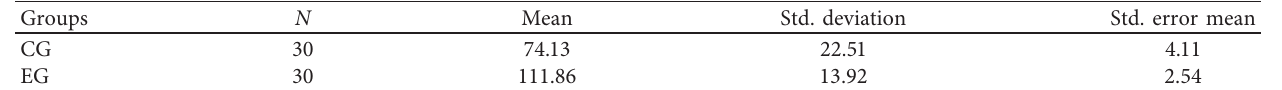
Table 7: Means and standard deviations of both groups on the reading motivation posttest.